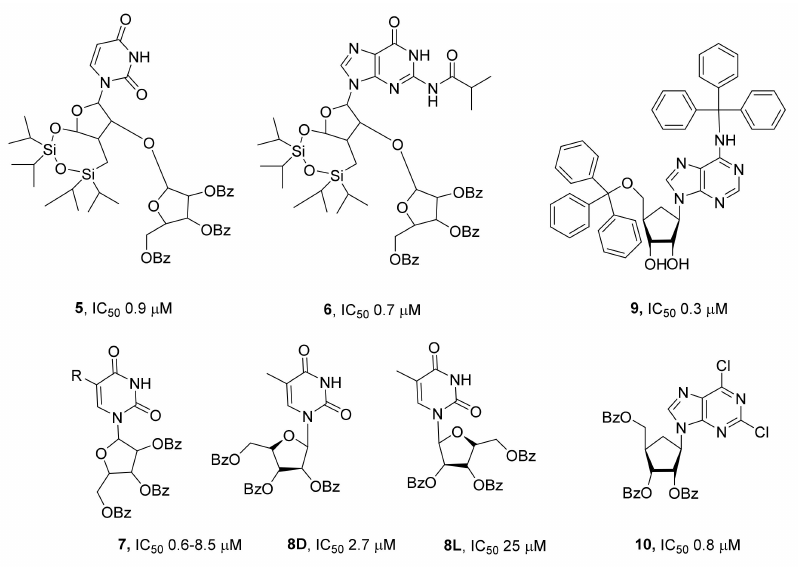
Figure 4. Nucleosides as inhibitors of